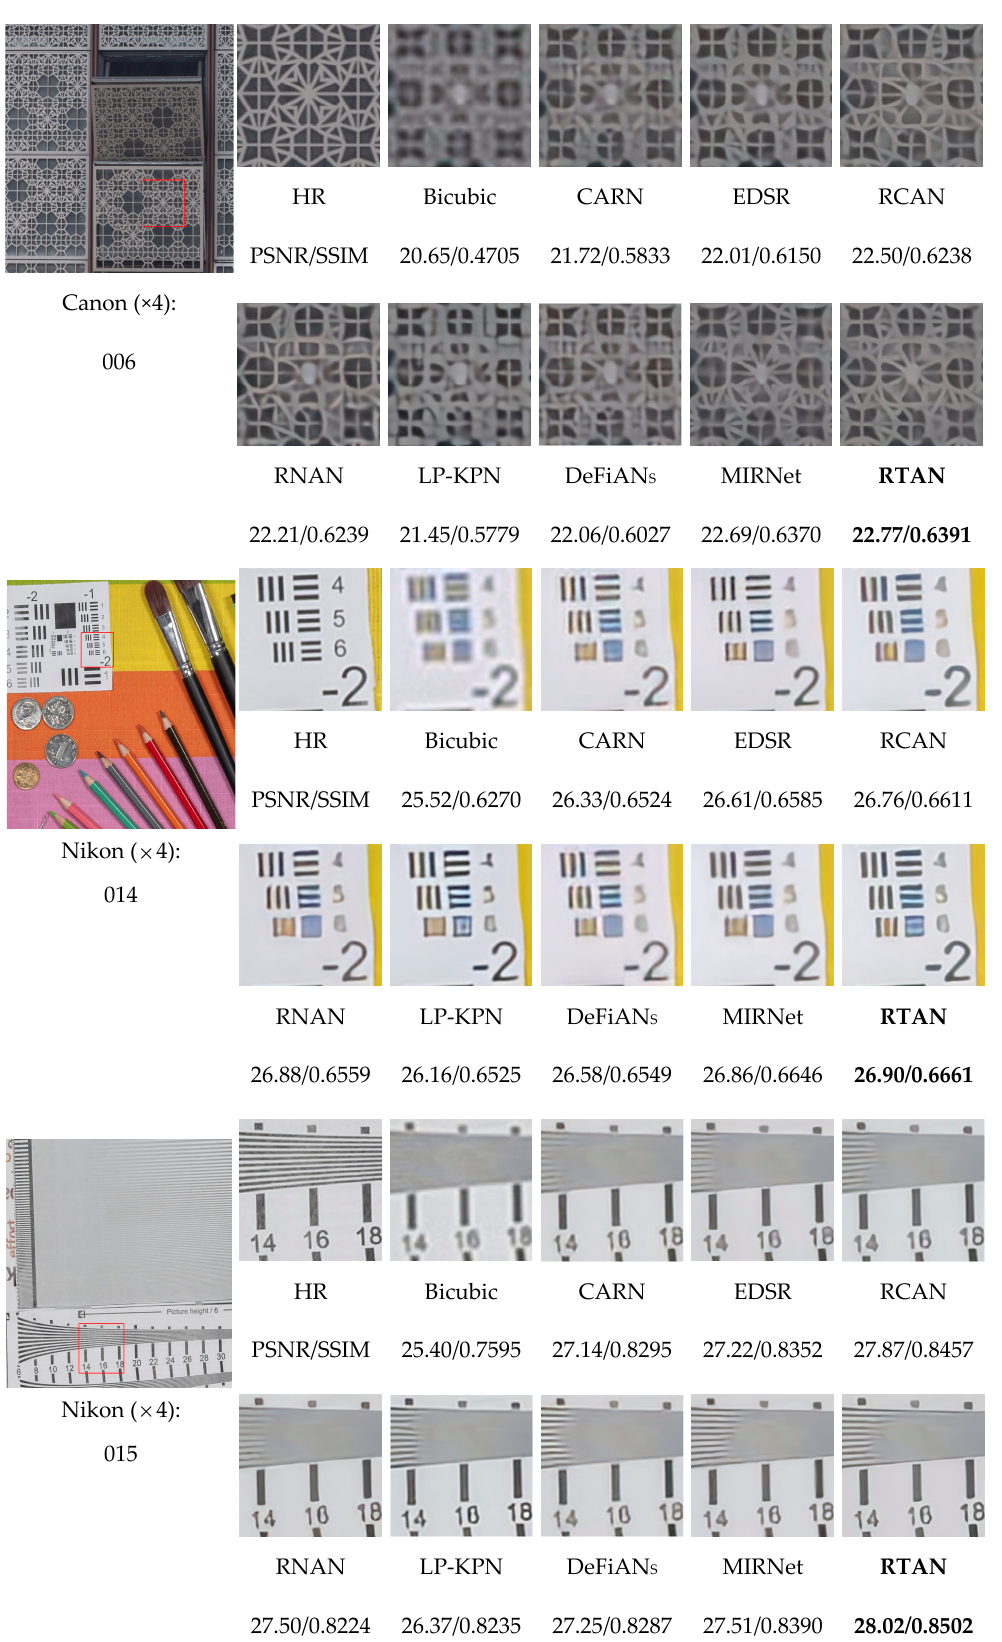
Figure 6. The visual comparisons for × 4 SR with real-world degradation model on Canon and Nikon datasets. The best results are highlighted.